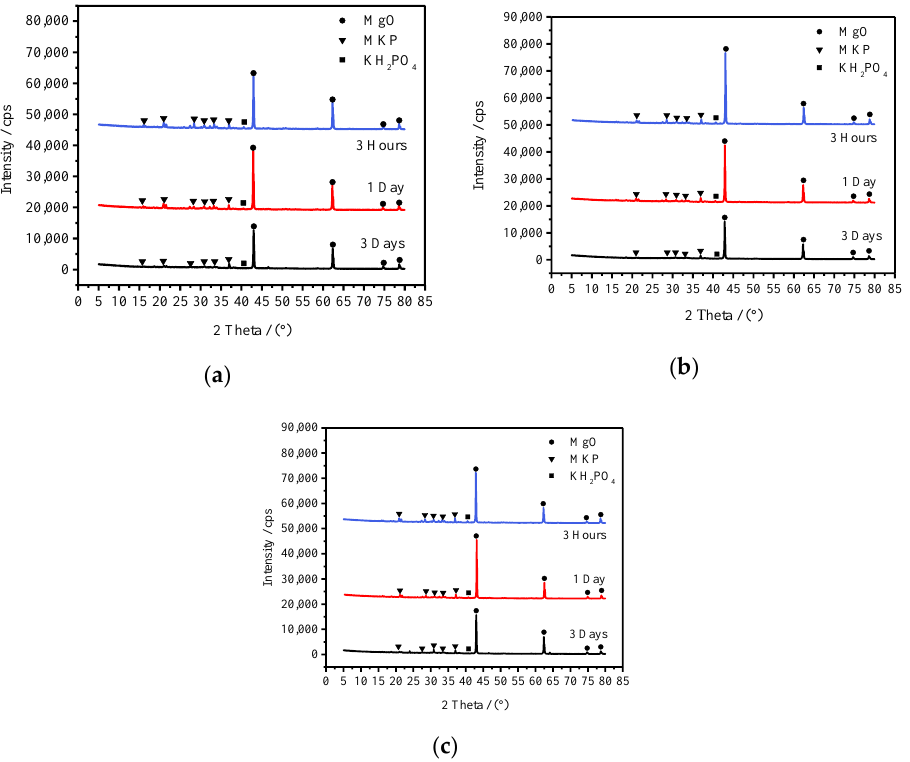
Figure 9. X-ray diffraction patterns of specimens. ( a ) Specimens with 0% MgCl, ( b ) Specimens with 2% MgCl, ( c ) Specimens with 4% MgCl. 2% MgCl, ( c ) Specimens with 4%